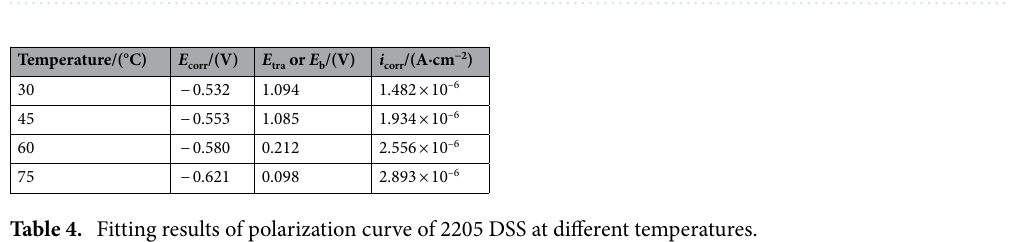
Figure 4. Dynamic potential polarization curve of 2205 DSS at different temperatures.